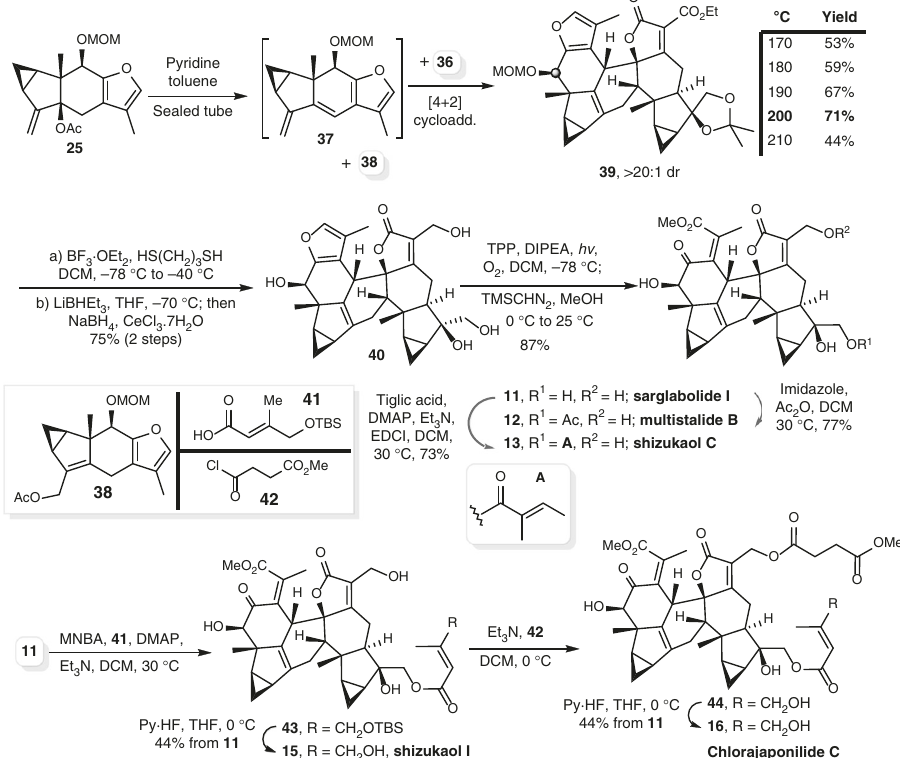
Fig. 5 Total syntheses of type 3 [4 + 2] lindenane dimers. TPP = 5,10,15,20-tetraphenylporphyrin, DMAP = N,N -4-dimethylaminopyridine, EDCI = 1-ethyl- 3-(3-dimethylaminopropyl)carbodiimide hydrochloride, MNBA = 2-methyl-6-nitrobenzoic anhydride